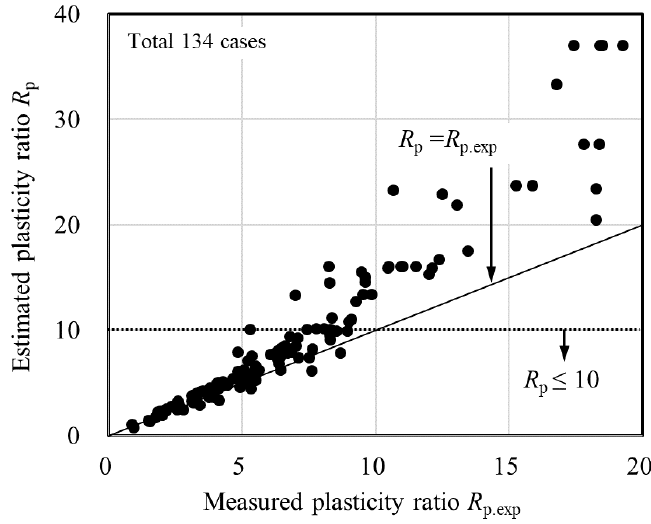
Figure 10. Investigation of the estimation accuracy based on the plasticity ratio R p .